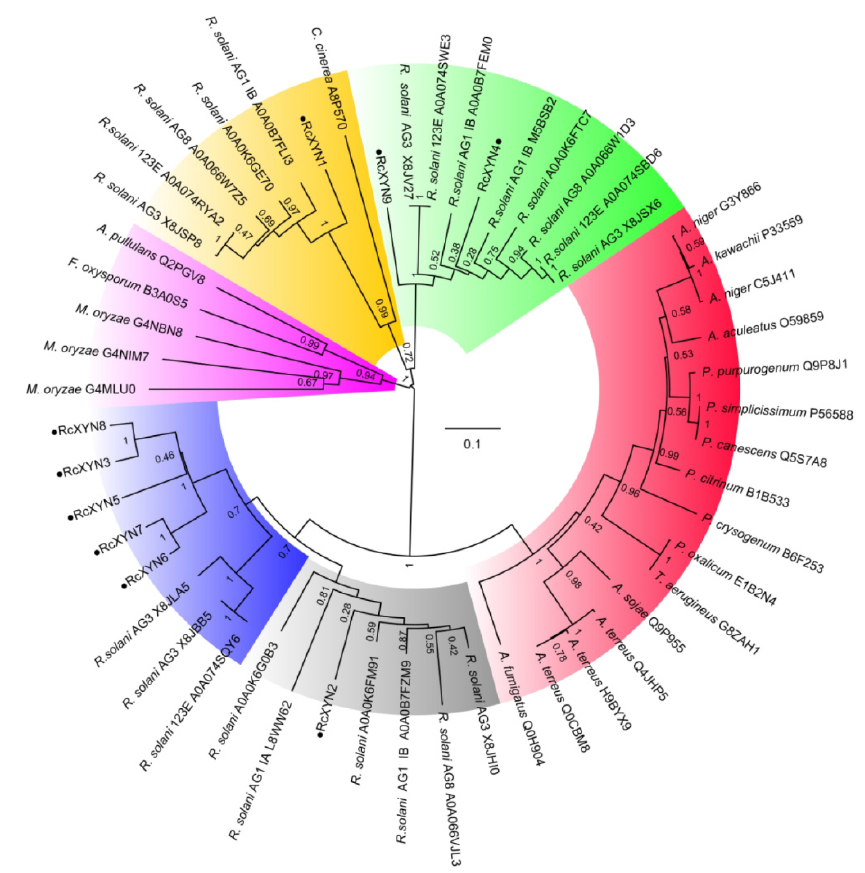
Figure 3. Phylogenetic relationships between GH10 xylanases from R. cerealis and other fungi. The phylogeny was constructed by Mega 7.0 using neighbor-joining method (parameters: 1000 bootstraps). Yellow represents group 1; Green represents group 2; Red represents group 3; Grey represents group 4A; Blue represents group 4B; Pink represents group 5.